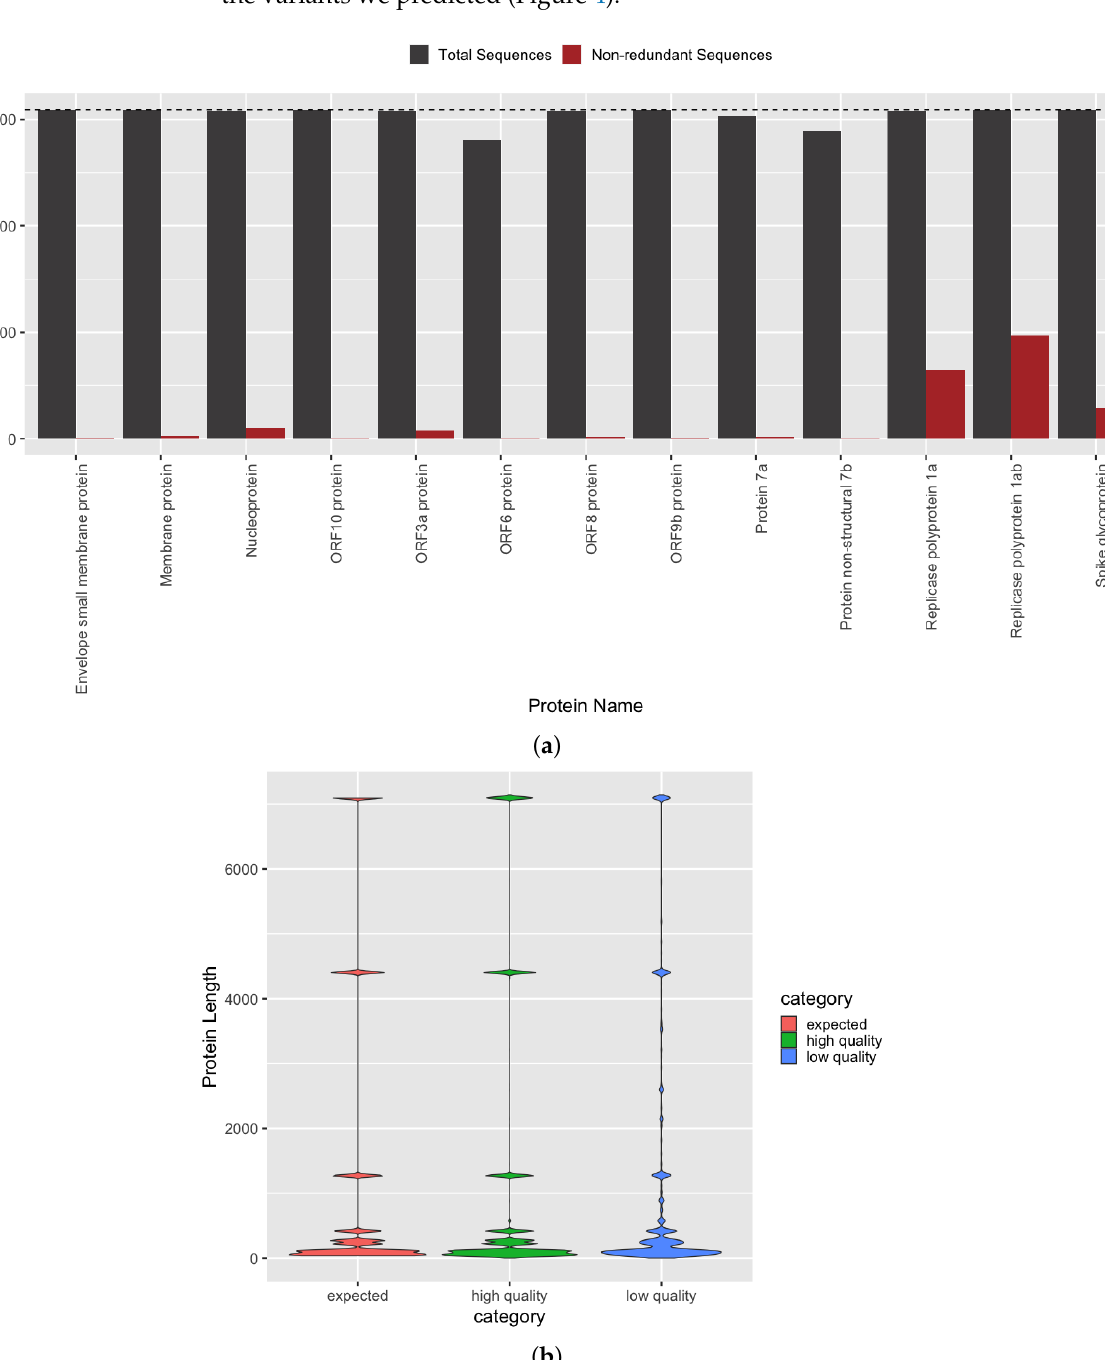
Figure 3. Protein annotation set membership and sequence accuracy. ( a ) Set membership of all (grey) and distinct (red) protein sequences identified in SARS-CoV-2 genomes above quality thresholds. Count indicates the number of times a given protein was observed in the entire high quality genome corpus (dashed line). ( b ) Protein size distribution of known protein references (expected, red) more closely matches our in silico predicted protein sequences from genomes above quality thresholds (high quality genomes, green), compared to products predicted from genomes below quality thresholds (low quality genomes,